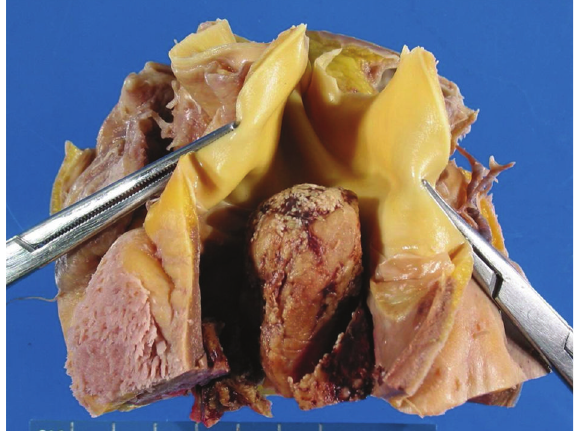
Figure 3: A postmortem view of the right ventricle shows the cardiac mass extending into the right ventricular outflow tract (held open by